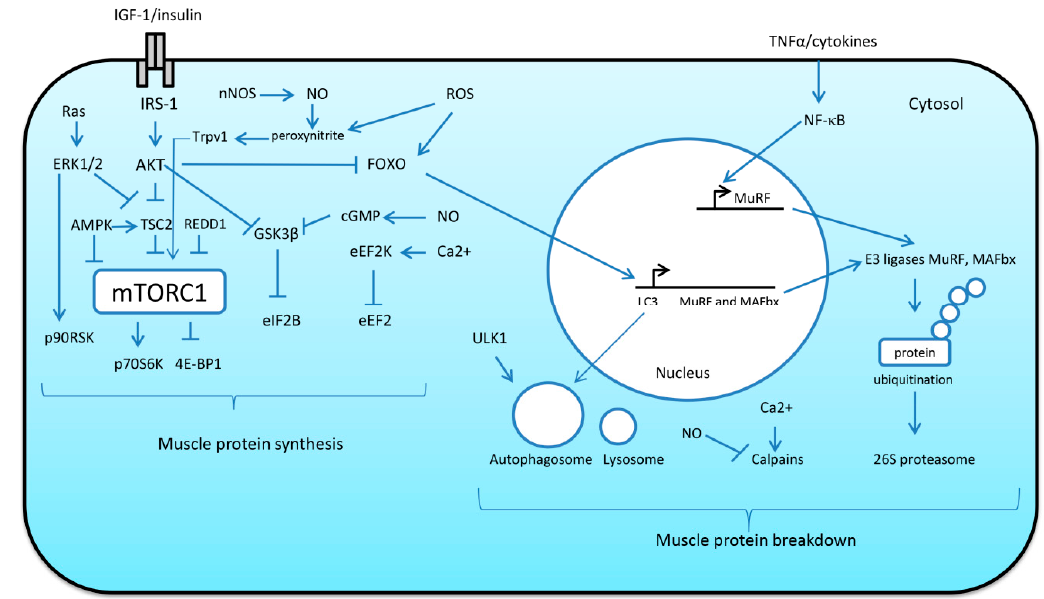
Figure 3. Simplified diagram delineating key signaling pathways involved in skeletal muscle protein synthesis and degradation. Arrows indicate stimulatory signals, whereas T bars represent inhibitory signals.